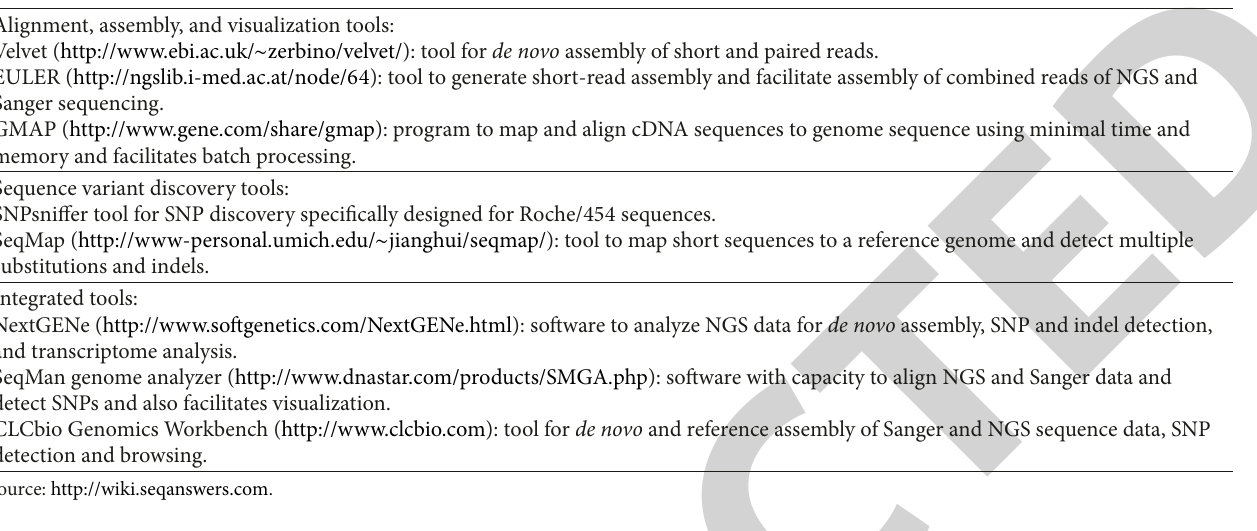
Table 1: Important bioinformatics tools for analysis of NGS data.